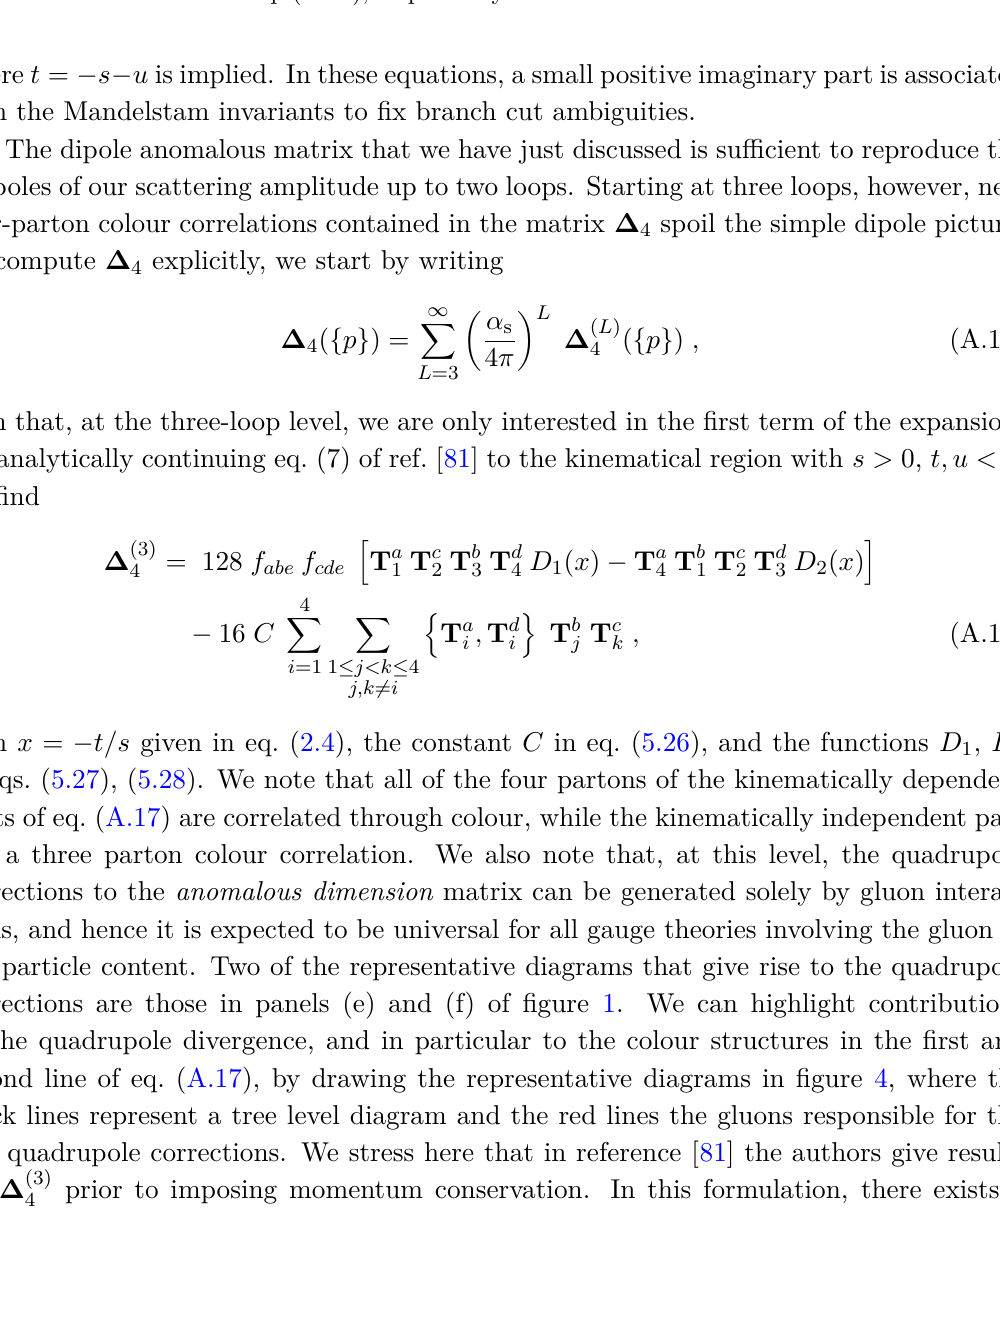
Figure 4 . Diagrams contributing to the quadrupole IR divergence, reinterpreted as tree level diagrams plus virtual gluons. Diagrams (a) and (b) give a contribution to the colour structures in the first and second line of eq. (A.17),